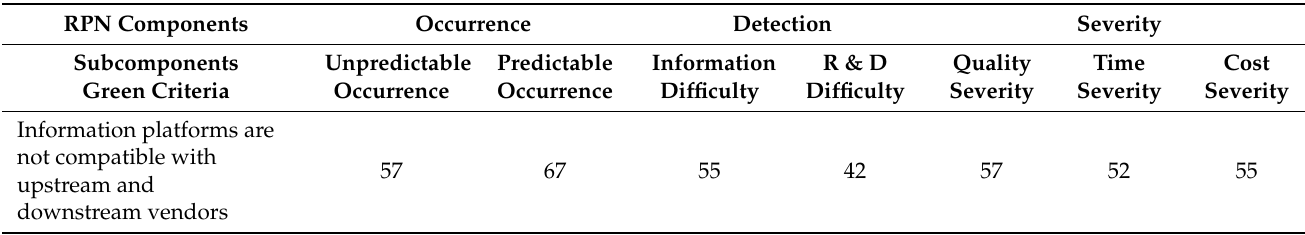
Table 4. The collected data between green design and RPN